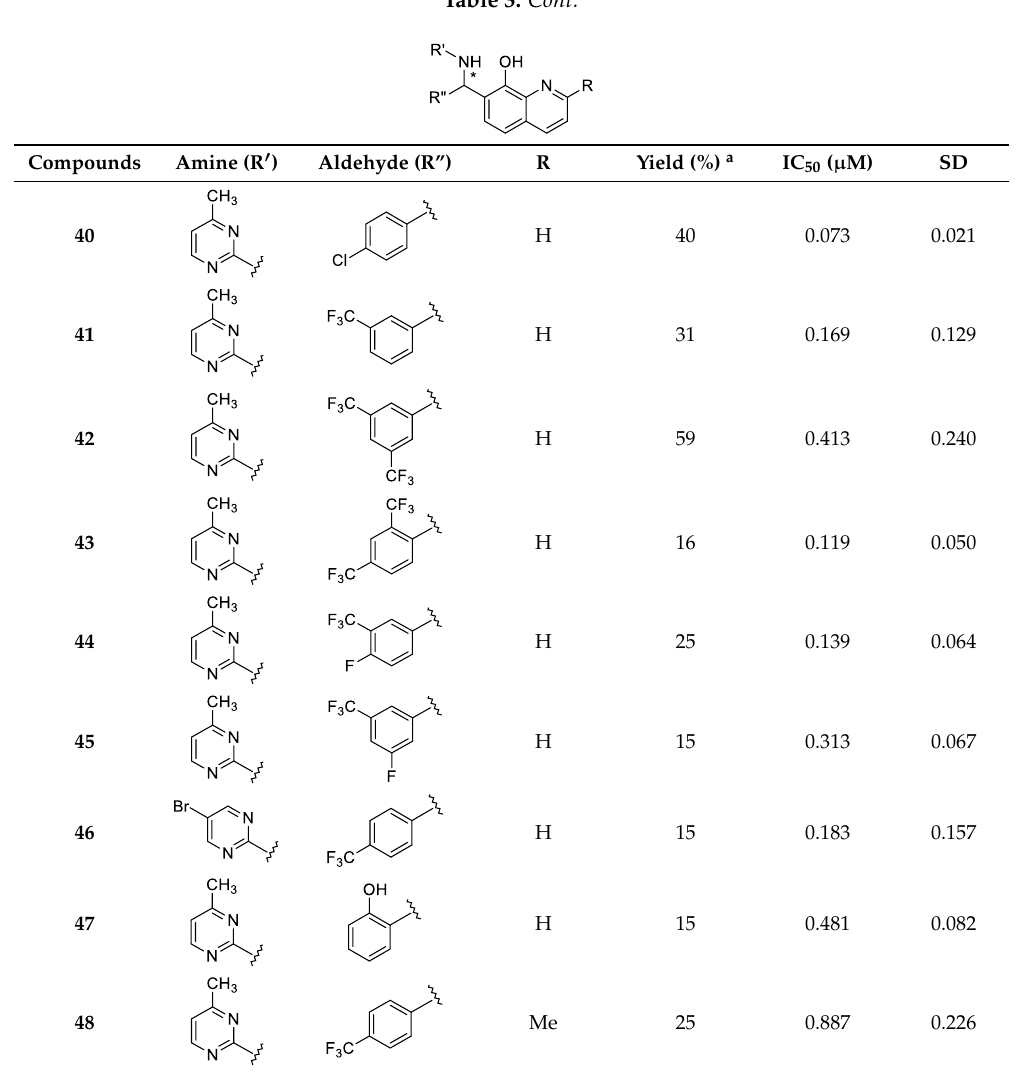
Table 3. Functionalization with several pyrimidines (Subclass 3).